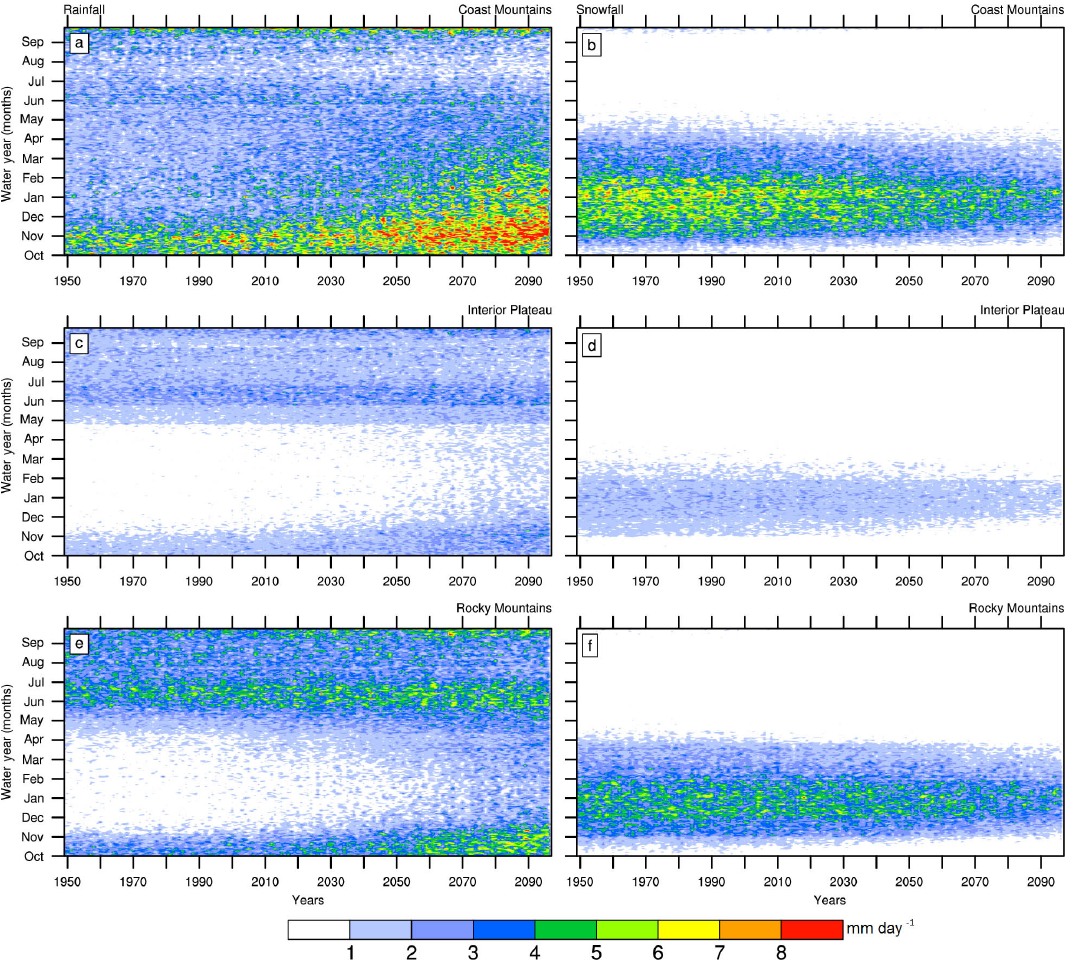
Figure 4. Partitioning of CMIP5 MME mean total precipitation into daily rainfall (a, c, e) and snowfall (b, d, f) for the Coast Moun- tains (a, b) , Interior Plateau (c, d) and Rocky Mountains (e, f) . Values are regional spatial averages over the three geoclimatic regions. Units are mmday − 1